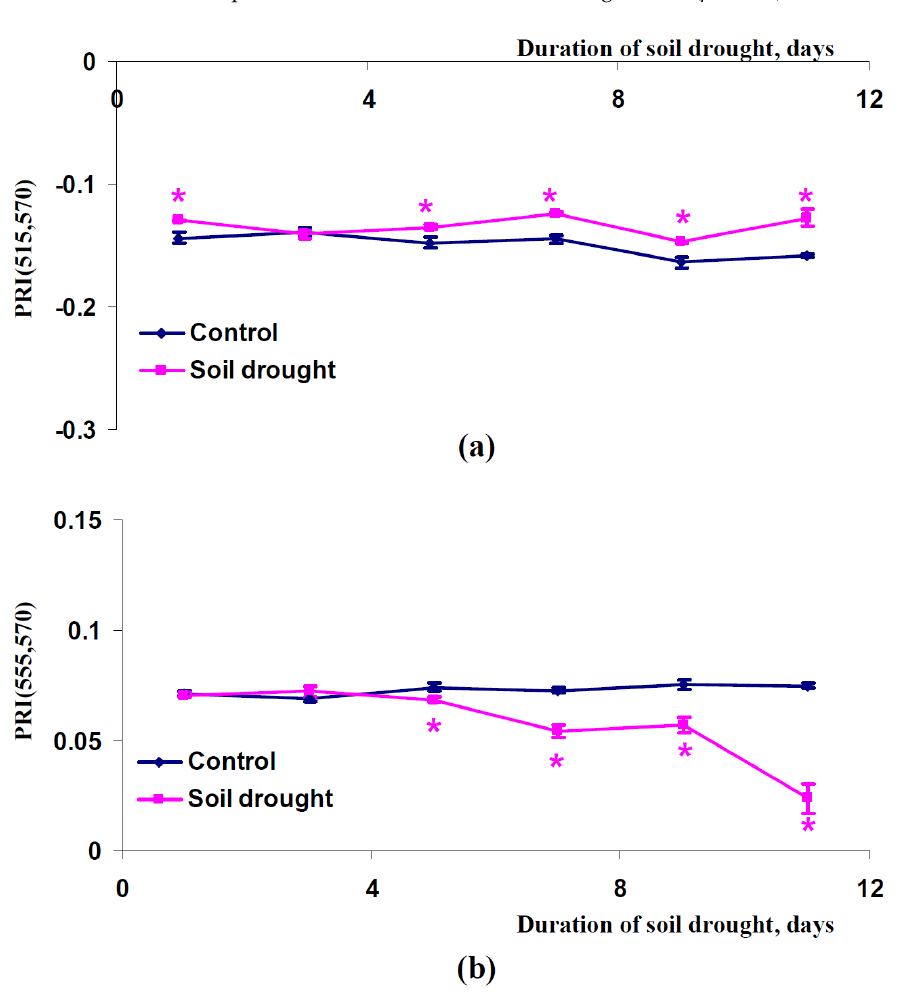
Figure 9. Dependences of the PRI(515,570) ( a ) and PRI(555,570) indices ( b ) in the canopy of wheat plants cultivated under open-ground conditions on the duration of the soil drought ( n = 45). *, difference between experimental and control indices was significant ( p < 0.05).